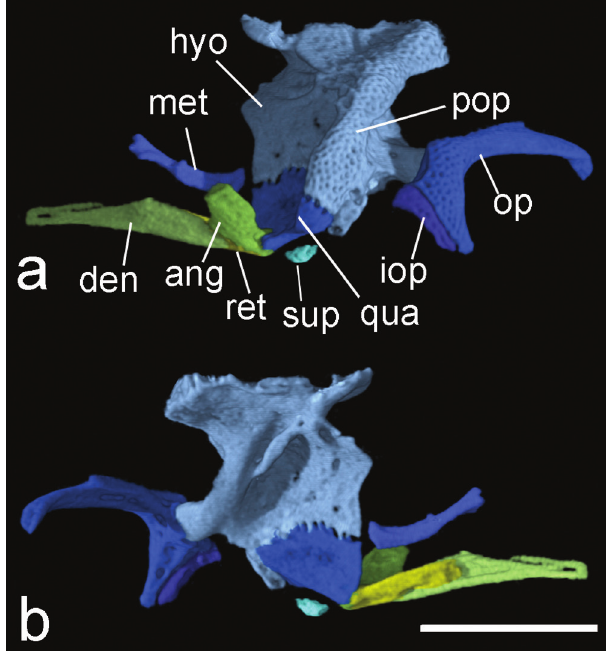
Fig. 5. HRXCT model of left side suspensorium and